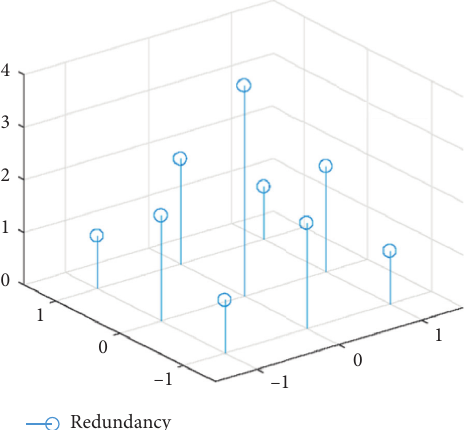
Figure 2: Redundancy in virtual